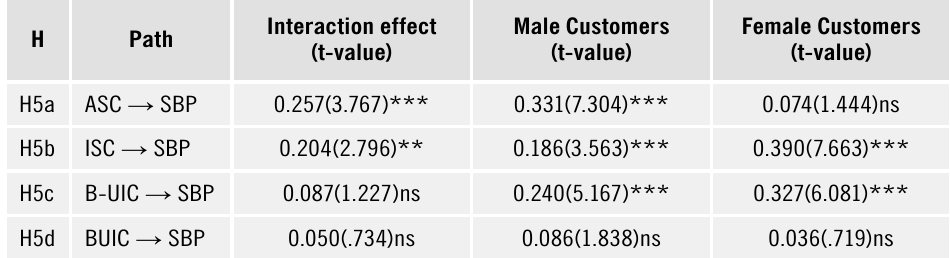
Table 3. Moderating effect of gender